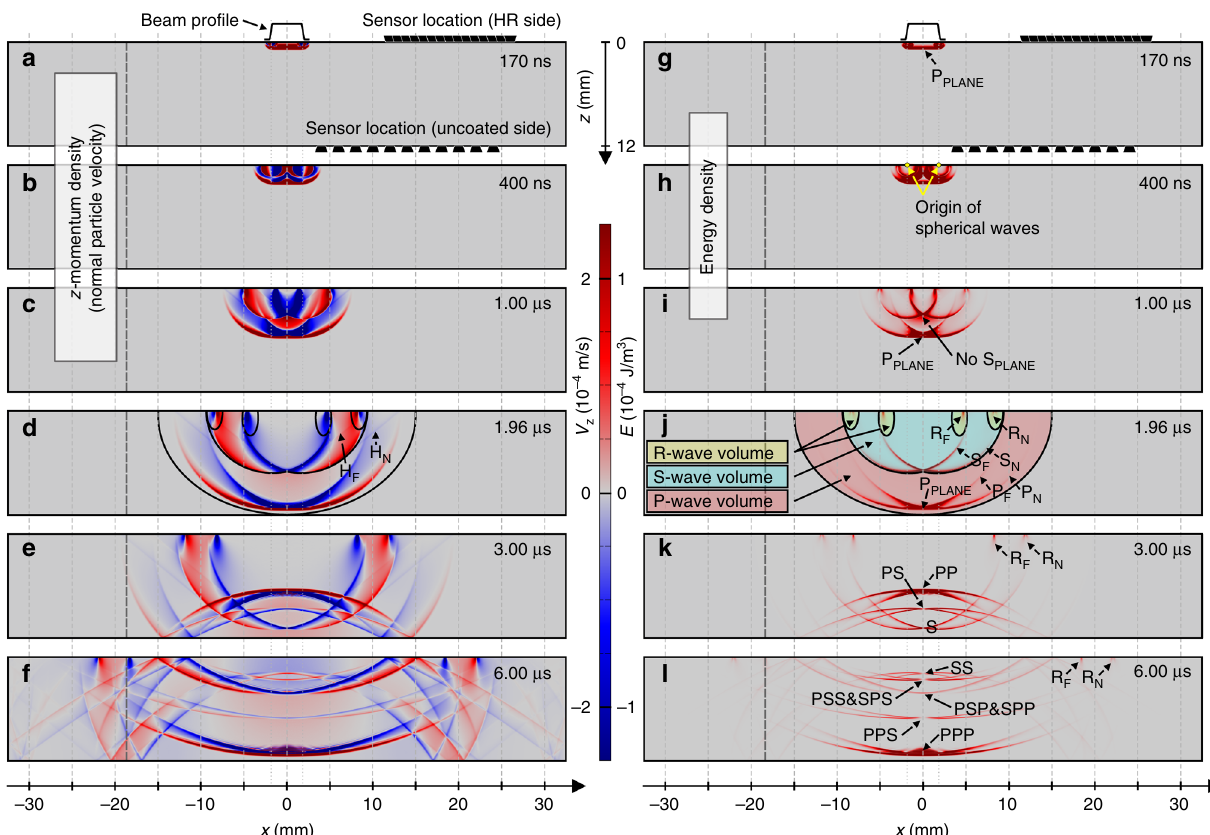
Fig. 4 Simulated propagation of radiation-pressure-driven elastic waves within a mirror. Six time frames reveal the temporal evolution of a – f the normal component of particle velocity fi eld v z , which is directly proportional to the normal component of momentum density, and g – l the mechanical energy density. The elastodynamic picture describes how z -momentum and energy are localized in various wave-types, each propagating with a different velocity. In the fi rst snapshot ( a , g ), taken at the end of illumination, the dominant disturbance is the plane P-wave. In the second ( b , h ) and third ( c , i ) snapshots, multicomponent waves originate from the edge of the interaction area and overlap. In the fourth snapshot ( d , j ), taken just before the P-wave reaches the bottom facet, these multicomponent waves decouple. In the fi fth snapshot ( e , k ), re fl ection and mode conversion of the P-wave is evident. In the sixth snapshot ( f , l ), the propagation and re fl ection of multiple elastic waves give rise to a complex pattern of mechanical disturbances. We use the fourth snapshot ( d , j ), to divide the disturbed volume into cylindrically symmetric subvolumes to categorize different wave-types and the resulting surface displacement at the sensor positions shown in black. Through this classi fi cation, we estimate that the P-waves carry 86%, S-waves 11%, and R-waves 3% of the total mechanical energy of 1.96 fJ. Interestingly, the transferred z -momentum of + 1.07 nNs equals twice the incident momentum of the light pulse and is mainly transported by the S-waves ( + 105%), while the negative z -momentum transported by the R-waves ( − 32%) is partially compensated by the positive z -momentum transported by the P-waves ( + 26%). A time evolution animation of the surface displacement and elastic waves within the mirror can be seen in the Supplementary